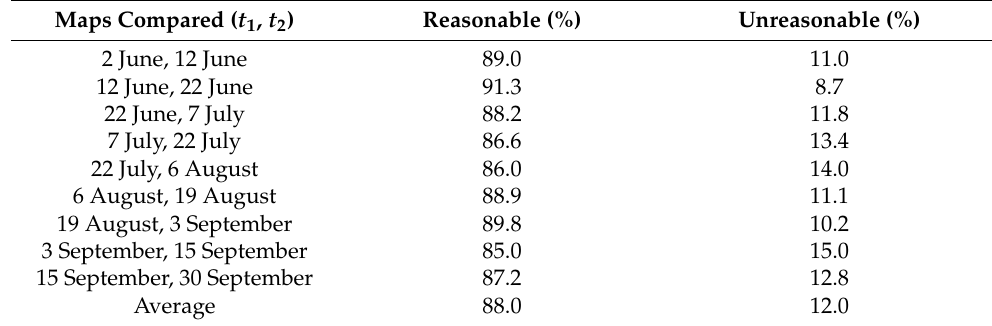
Table 7. Results of the comparisons of contiguous couples of multitemporal maps. Maps Compared ( t 1 , t 2